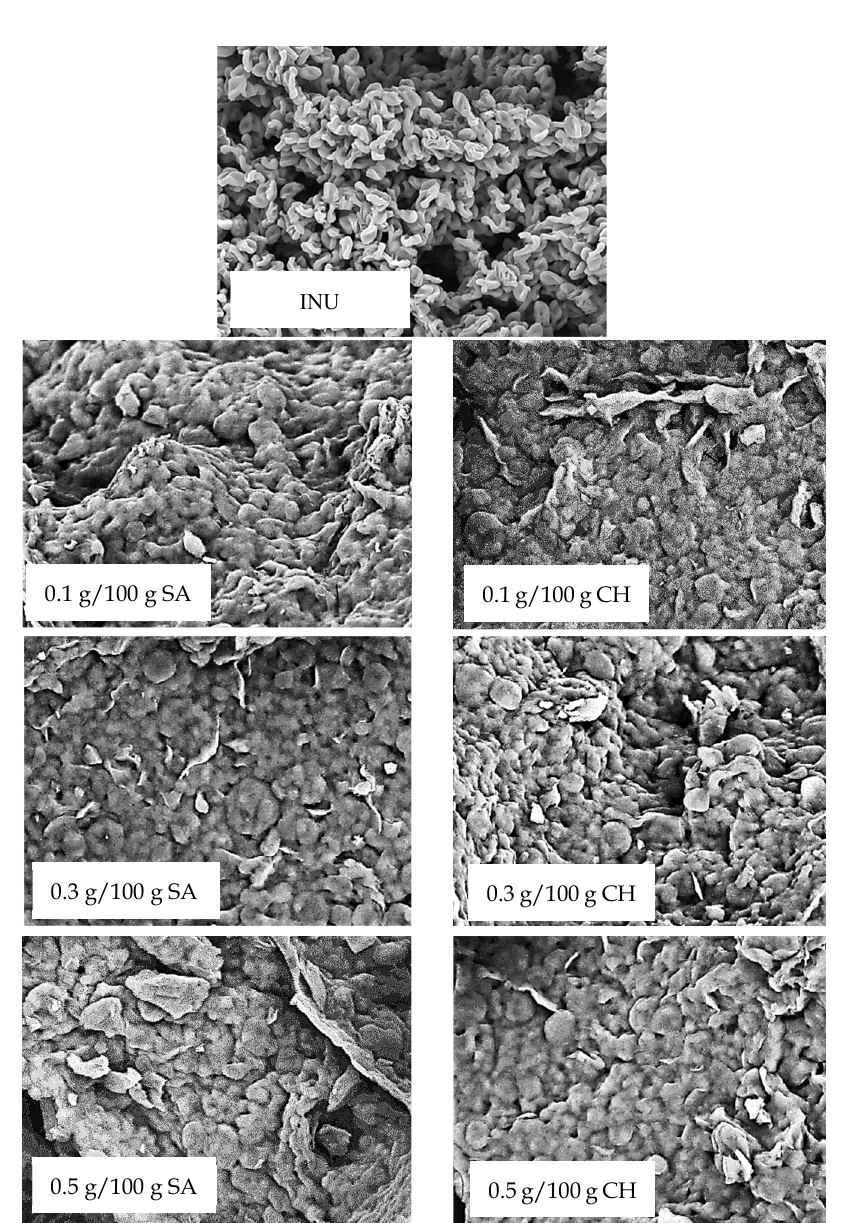
Figure 1. Effect of sodium alginate (SA) and chitosan (CH) addition on the microstructure of inulin hydrogels (magnification ×3000). Table 1. Effect of sodium alginate (SA) and chitosan (CH) addition on the physical properties of inulin hydrogels.